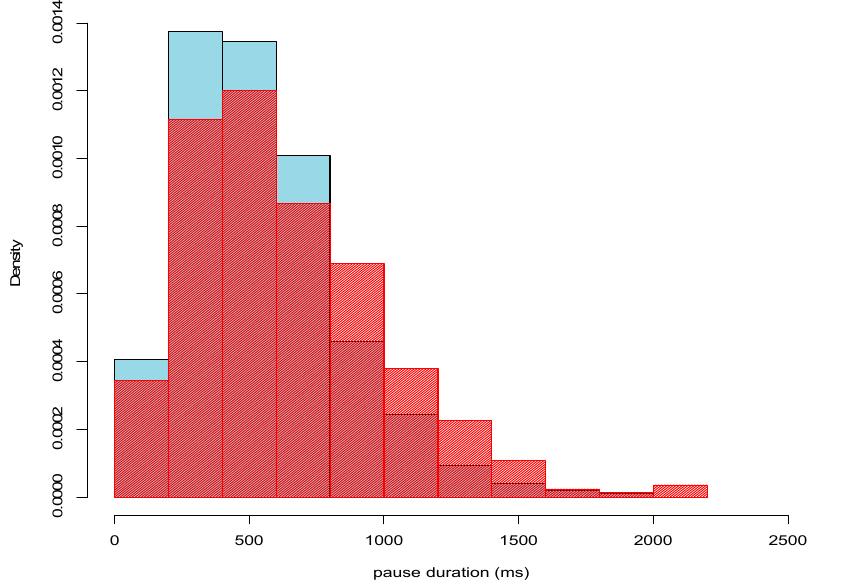
Histograms of pause duration (blue = female, red = male)